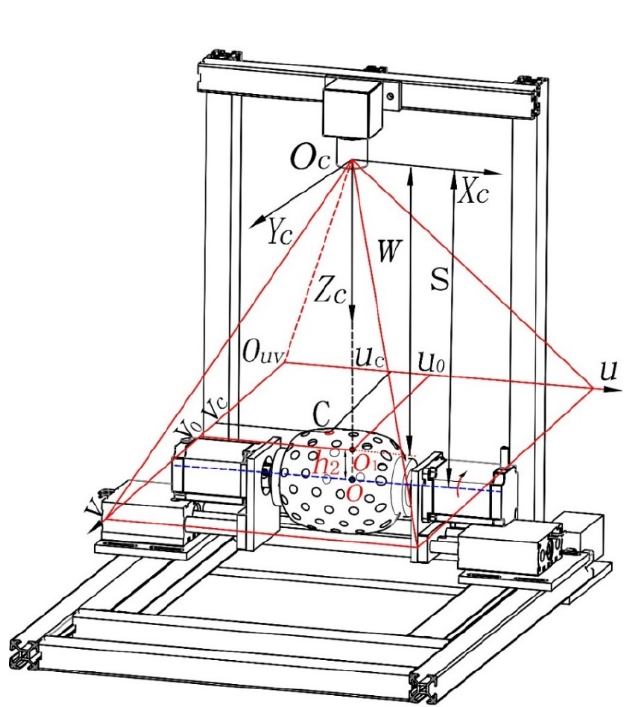
Figure 6. Camera coordinate system for the pineapple eye.